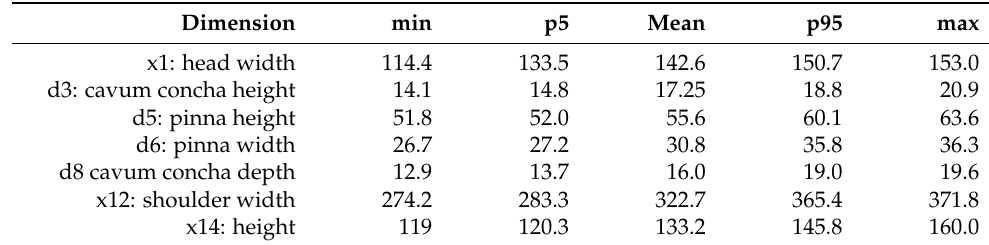
Table 1. Statistical summary of selected anthropometric measures in the database in [mm]. The